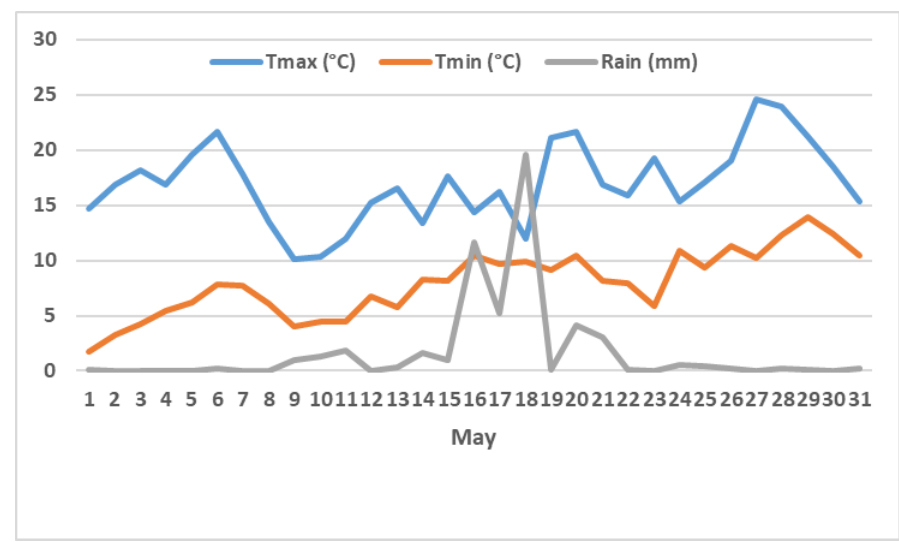
Figure 1. Minimum (Tmin), maximum (Tmax), and rain fall in May 2017 at NIBIO Ullensvang (Norwegian Institute of Bioeconomy Research), Norway.